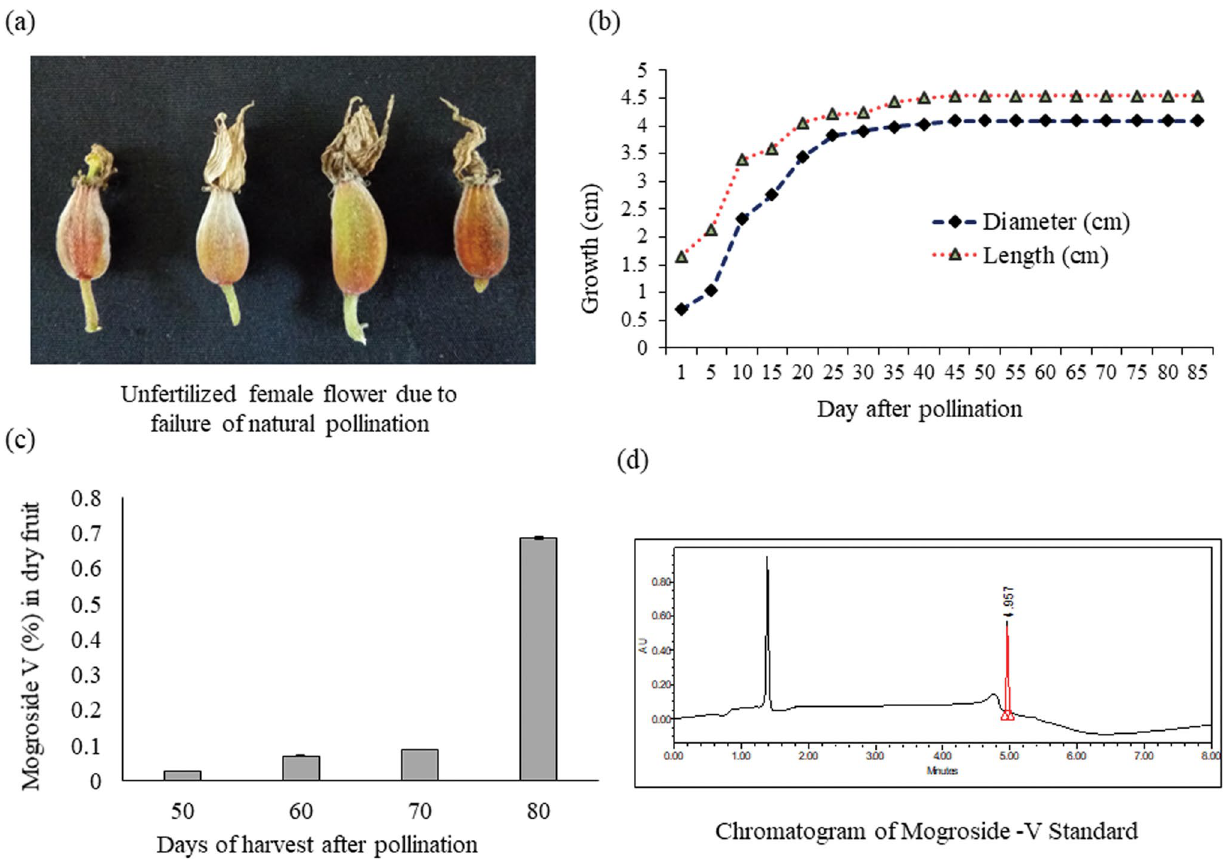
Figure 7. Unfertilized female flower due to failure of natural pollination (a) ; growth pattern of monk fruit (b) ; dynamic of mogroside-V accumulation in fruits (c) ; and chromatogram of mogroside-V standard (d)